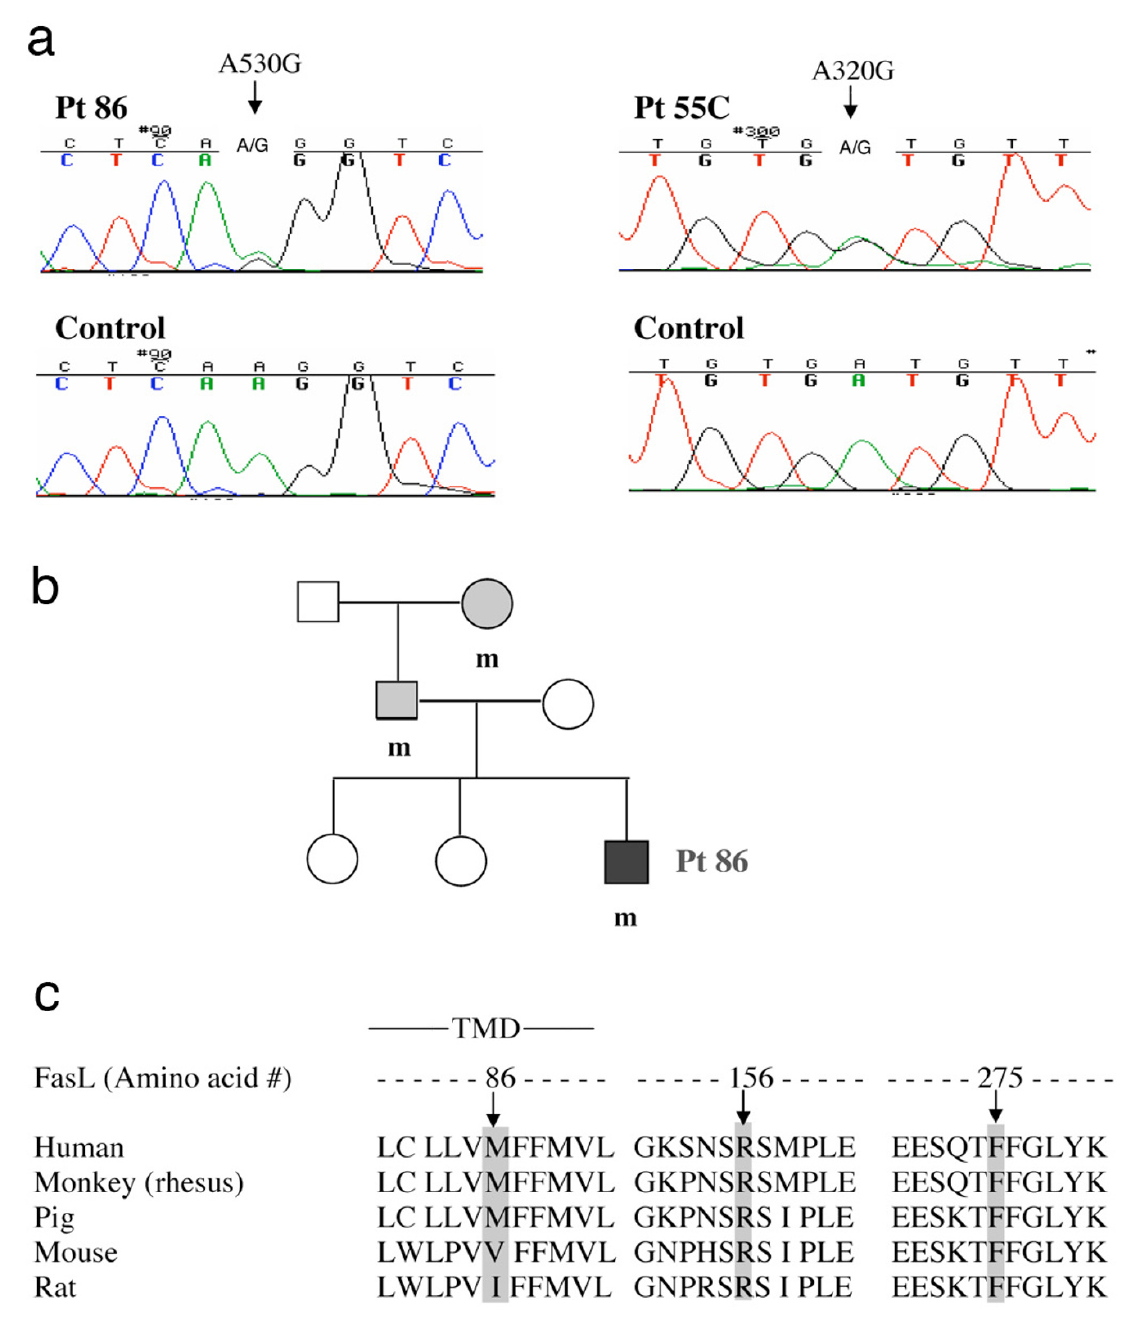
Figure 1 Fas ligand mutations in the Pt 86, Pt 55C and the gld mouse. Sequencing of genomic DNA shows a heterozygous A530G muta- tion in Pt 86 and a A320G mutation in Pt55C depicted in panel (a) for double peaks of A and G from normal and mutant alleles amplified from genomic DNA. The family pedigree in panel (b) reveals the same mutation was found in his father, and paternal grandmother (labeled with m) but not in his healthy mother or two sisters. Black, the affected individual; gray, individuals with the mutation but not the full picture of ALPS. This mutation leads to an amino acid change of A156G, the heterozygous A320G mutation found in Pt 55C FasL genomic DNA leads to an amino acid change M86V in the transmembrane domain (TMD), and the gld mutation in mouse is shown at amino acid site 275, all compared to the wild type sequences at these sites in 5 species, as aligned in panel c